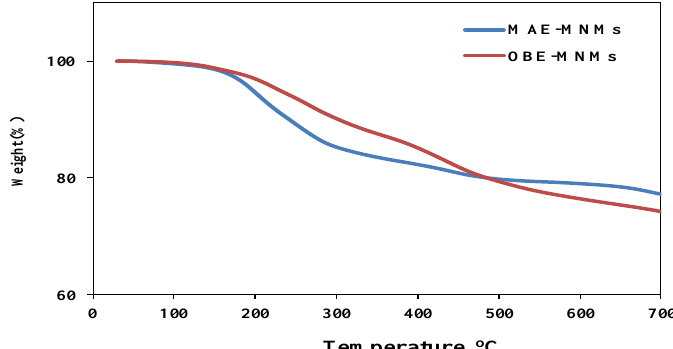
Figure 3. TGA thermograms of magnetite nanomaterials coated by M. aurea extract (MAE-MNMs) (blue curve) and by O. baccatus extract (OBE-MNMs) (red curve).